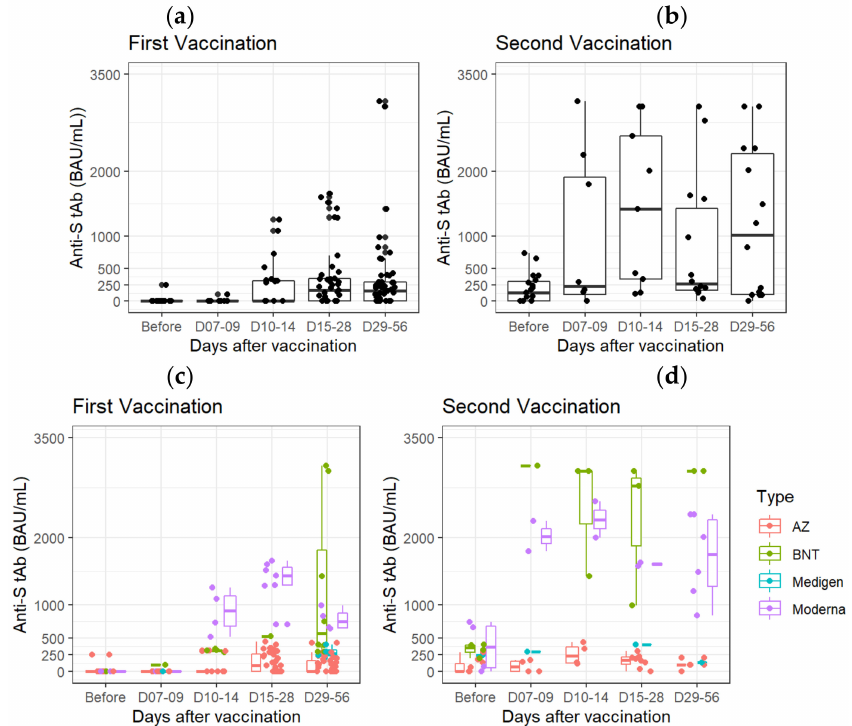
Figure 7. Follow-up and comparison of total anti-SARS-CoV-2 S protein antibody concentrations after the first ( a , c ) and second ( b , d ) vaccination. ( a , b ) All brands of vaccines; ( c , d ) different brands of